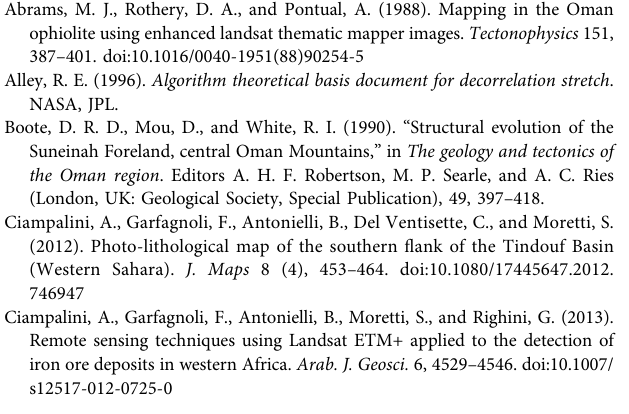
Frontiers in Earth Science |